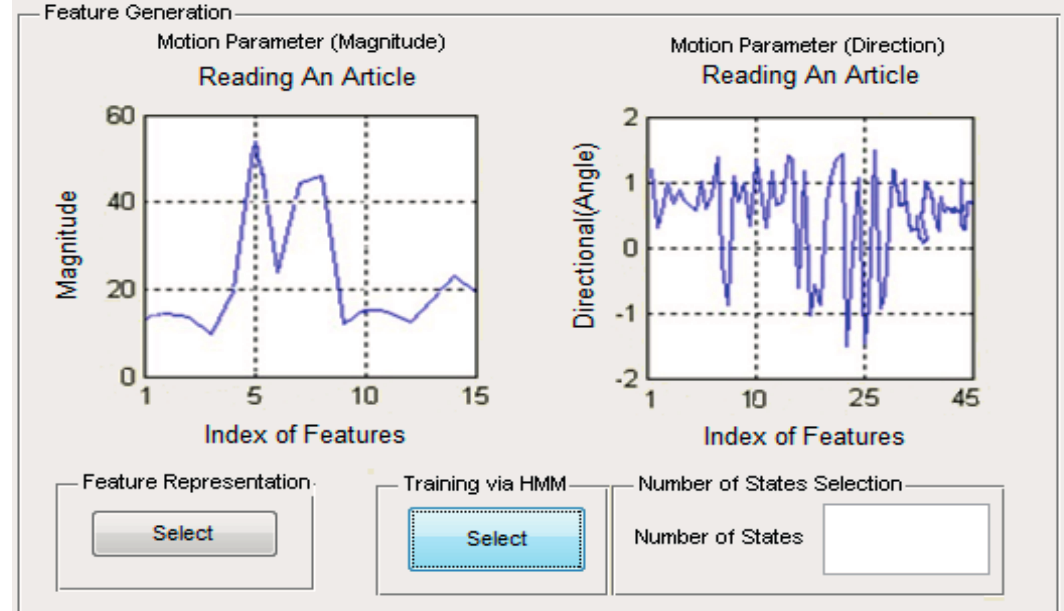
Figure 13. Feature generation and trained via HMM interface using different activities of life logging HAR